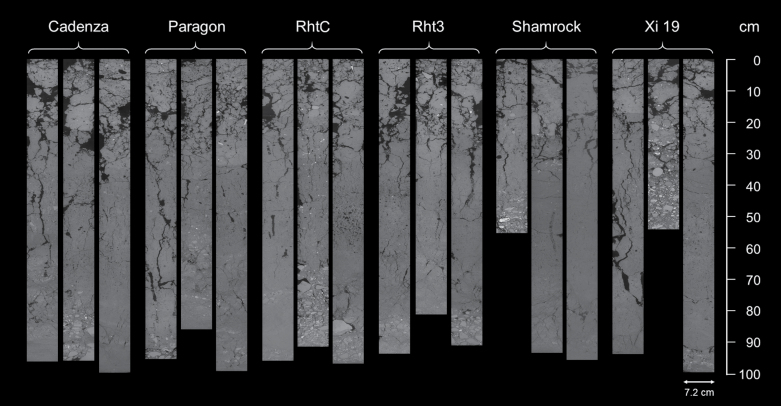
Soil longitudinal sections taken from the centre of the soil cores. Darker colours are soil pores, brighter grey colours are soil matrix.